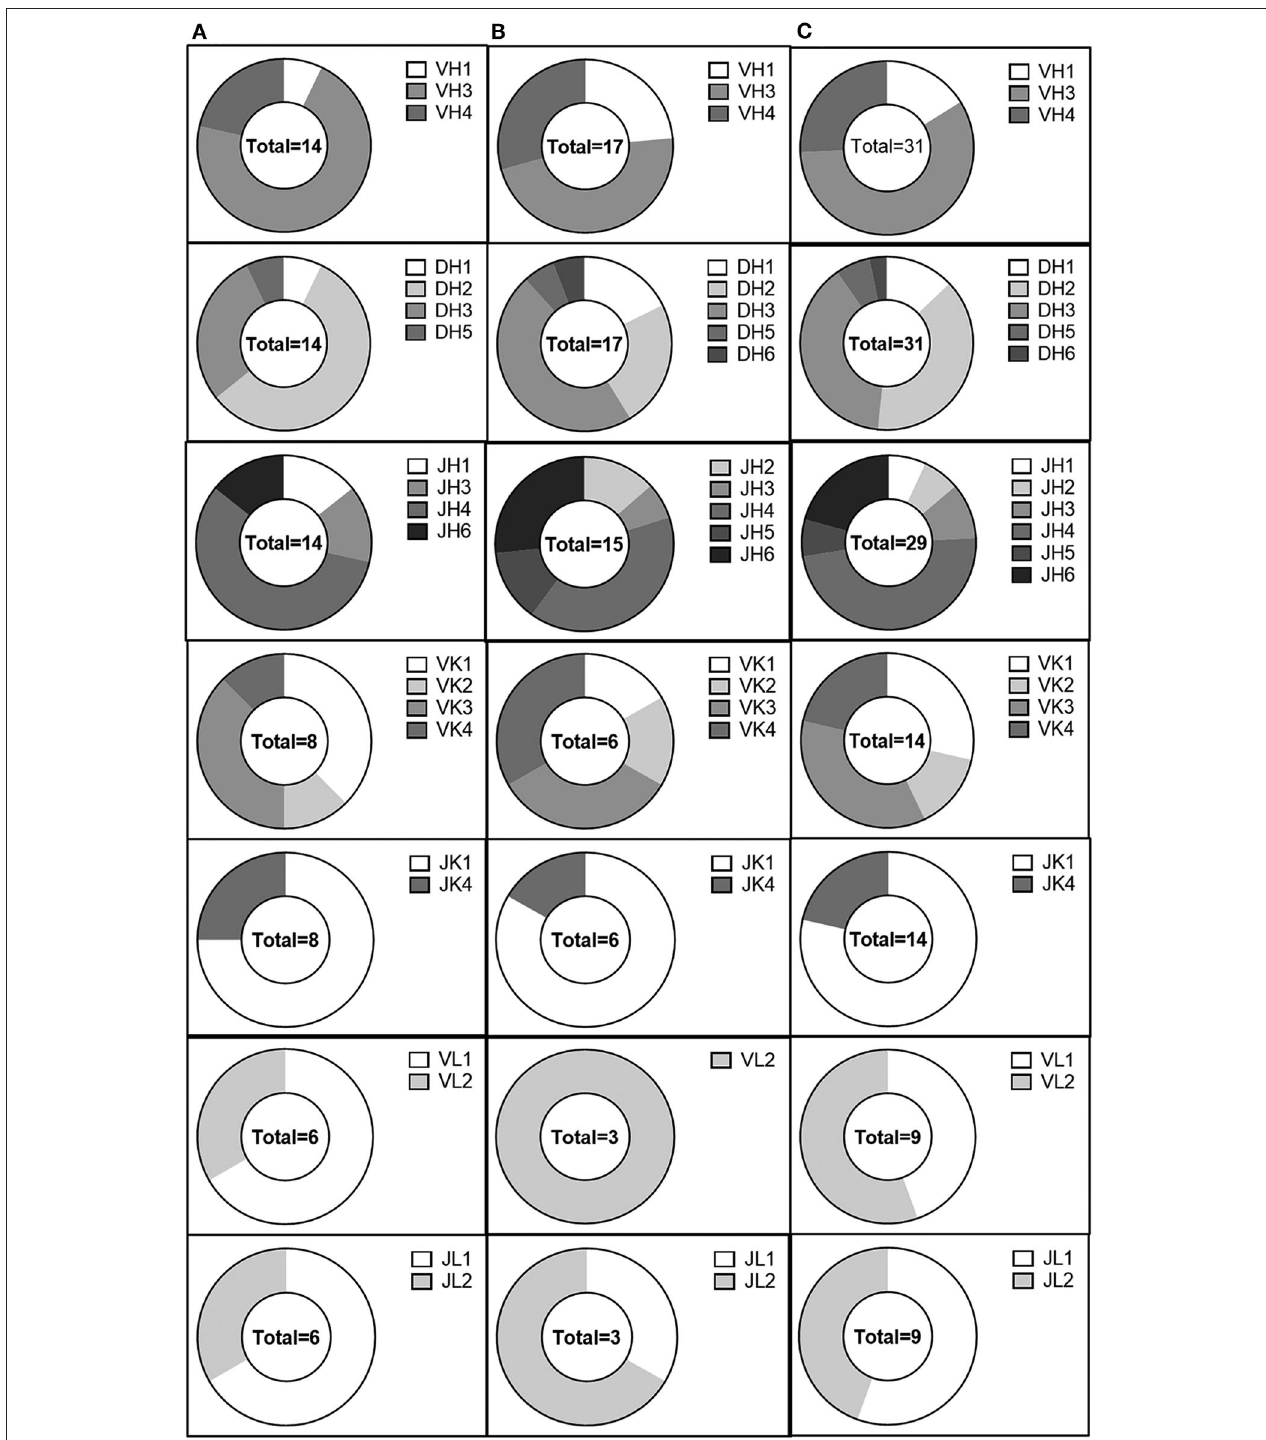
FIGURE 5 | Analysis of the AAV memory B-cell IgG gene repertoire. IgH V, D, and J, IgK V, and J, and IgL V and J gene distribution in (A) validated, (B) non-validated, and (C) total cloned sequences.